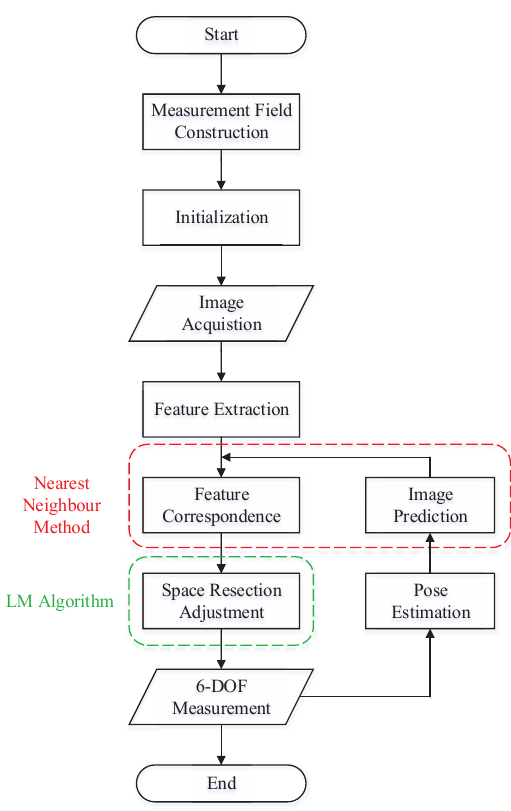
Figure 7. Dynamic six-degree-of-freedom (6-DOF) measurement process.